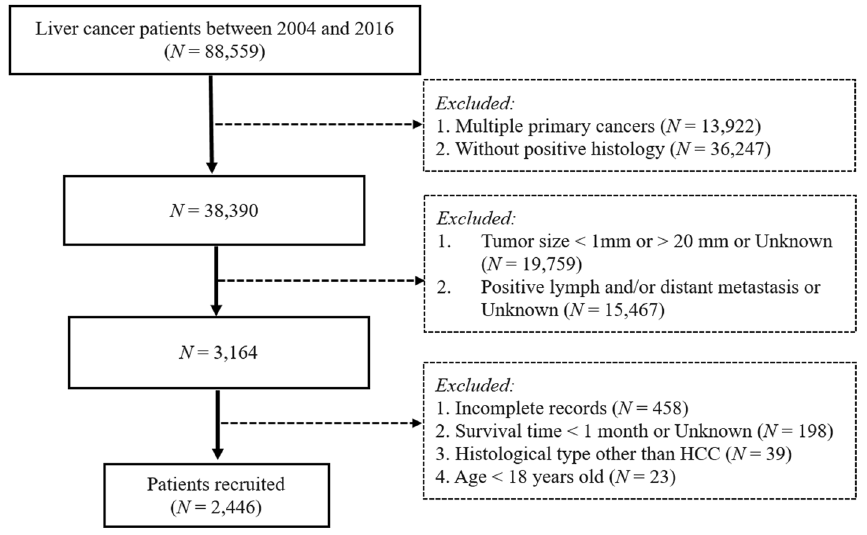
Figure 1. Patient selection